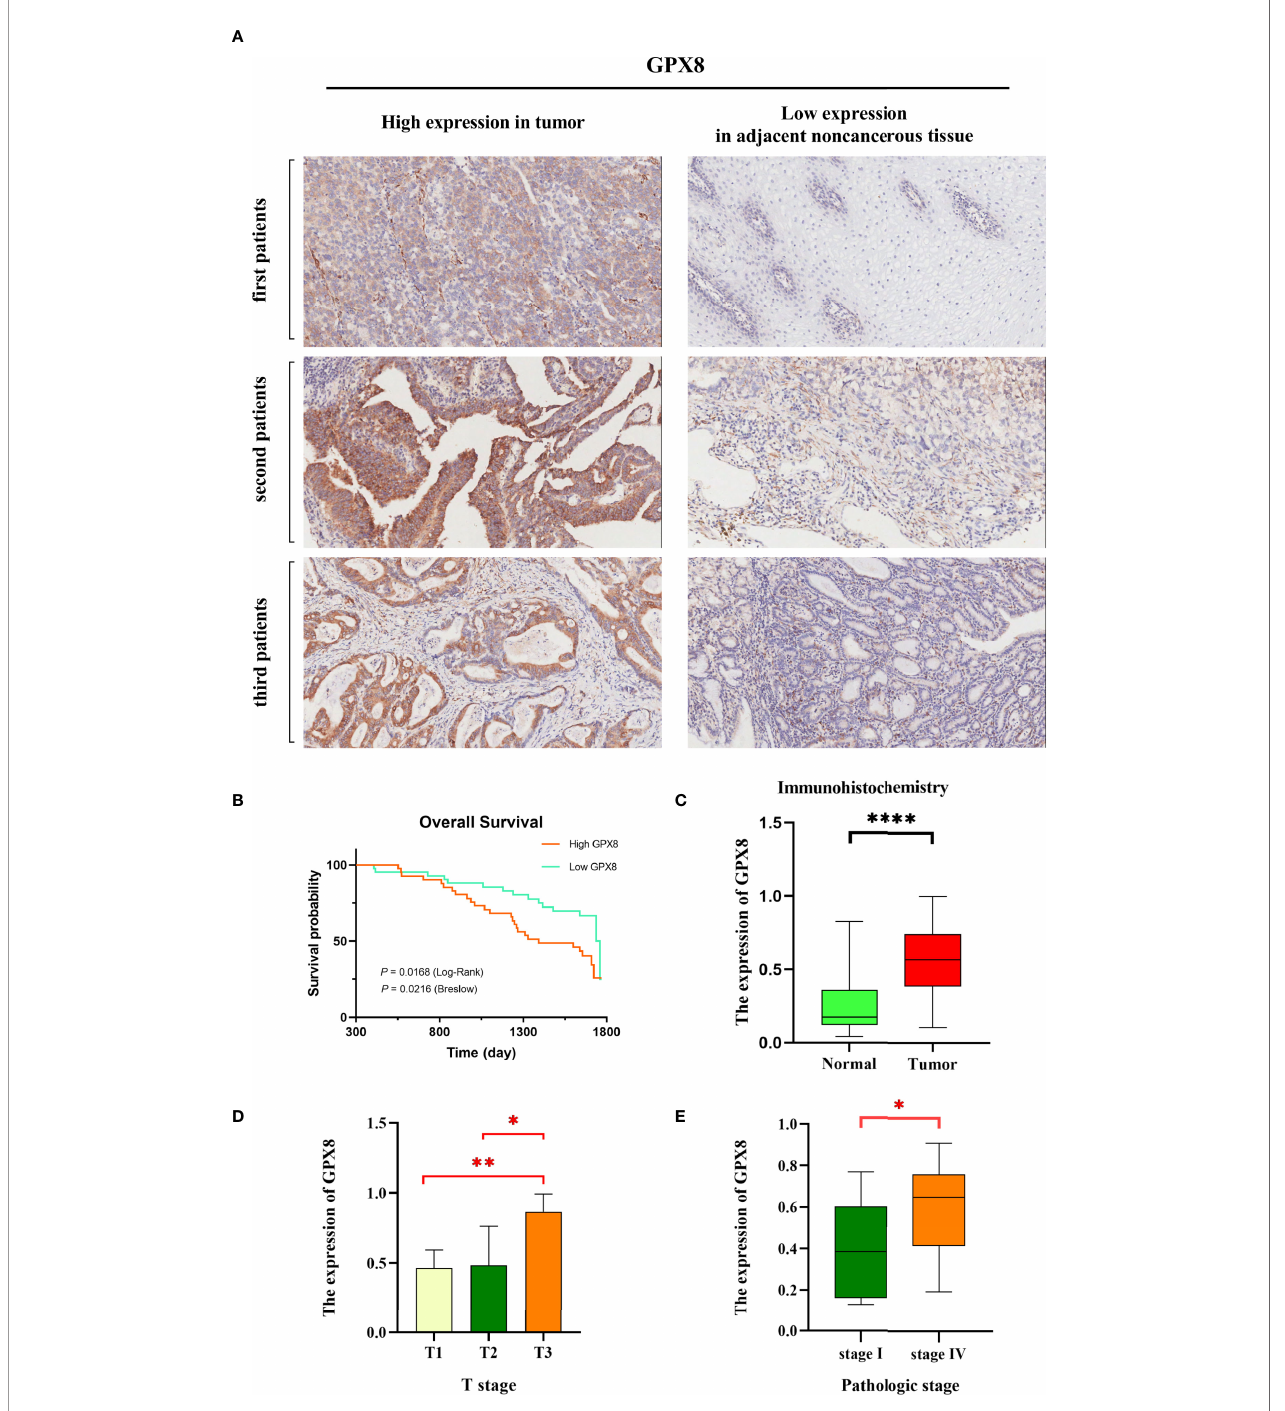
FIGURE 11 | GPX8 gene expression levels were associated with clinical outcomes. (A) We selected six representative immunohistochemical pictures to show the expression of GPX8 in tumor and adjacent noncancerous tissues. (B) The Kaplan – Meier curve showed that a low GPX8 expression was associated with higher OS in stomach cancer patients, and the P value was calculated by log-rank ( P = 0.0168) and Breslow ( P = 0.0216). (C) The expression of GPX8 in tumor is higher than that in normal tissues. (D, E) There is a signi fi cant difference in the level of GPX8 expression between different groups, such as T1 vs. T3 ( P = 0.0091) in the T stage, T2 vs. T3 ( P = 0.0451) in the T stage, and stage I vs. stage IV ( P = 0.0416) in the pathologic stage. *, p < 0.05; **, p < 0.01; ****, p <